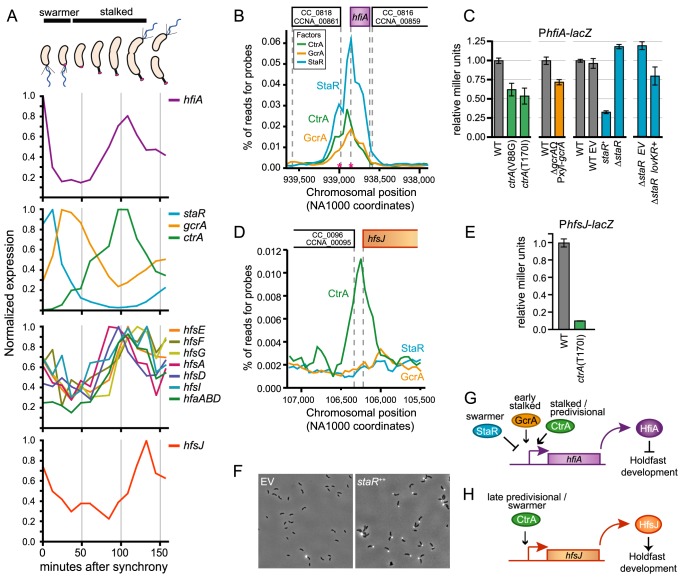
Transcription of hfiA is coordinately controlled by multiple regulatory proteins.
A. Cell cycle-dependent transcriptional regulation of genes involved in holdfast development. Data were extracted from global transcriptional profiling experiments [33] and normalized to maximal expression for each gene. Approximate developmental stage at each time point is shown at top. B. The core cell cycle regulators StaR, CtrA and GcrA occupy the hfiA promoter. ChIP-seq data of the hfiA locus for each regulator. Chromosomal position of DNA pulled down with each of the regulators is indicated below; the gene context is indicated above. Pink asterisks indicated mapped transcriptional start sites for hfiA. C. β-galactosidase activity from a PhfiA-lacZ transcriptional fusion (pRKlac290-PhfiA) assayed in strains bearing temperature sensitive alleles of ctrA outgrown in PYE at 37°C for 4 hours, in gcrA depletions strains grown in the absence of xylose (PYE+0.15% glucose) for 6 hours, and in strains in which staR was deleted or overexpressed from the Pxyl promoter (PYE+0.15% xylose). In each experiment, Miller units were normalized to WT grown in parallel conditions. Data represent mean ± s.d. of 6 independent cultures assayed on two different days. D. CtrA, but not GcrA or StaR, occupies the hfsJ promoter. ChIP-seq data for the hfsJ locus annotated as in B. E. CtrA activates transcription from the hfsJ promoter. β-galactosidase activity from a PhfsJ-lacZ transcriptional fusion in wild-type and ctrA
ts strains at restrictive temperature (37°C for 3 hours). Data represent mean ± s.d. of 4 independent cultures assayed on two different days. F. WGA-Alexa594 staining of holdfast in wild-type empty vector (EV) control strain or a staR
++ overexpression strain grown in M2X. G. Model of the hfiA regulatory activities of CtrA, GcrA and StaR. H. Model of the hfsJ regulatory activities of CtrA.